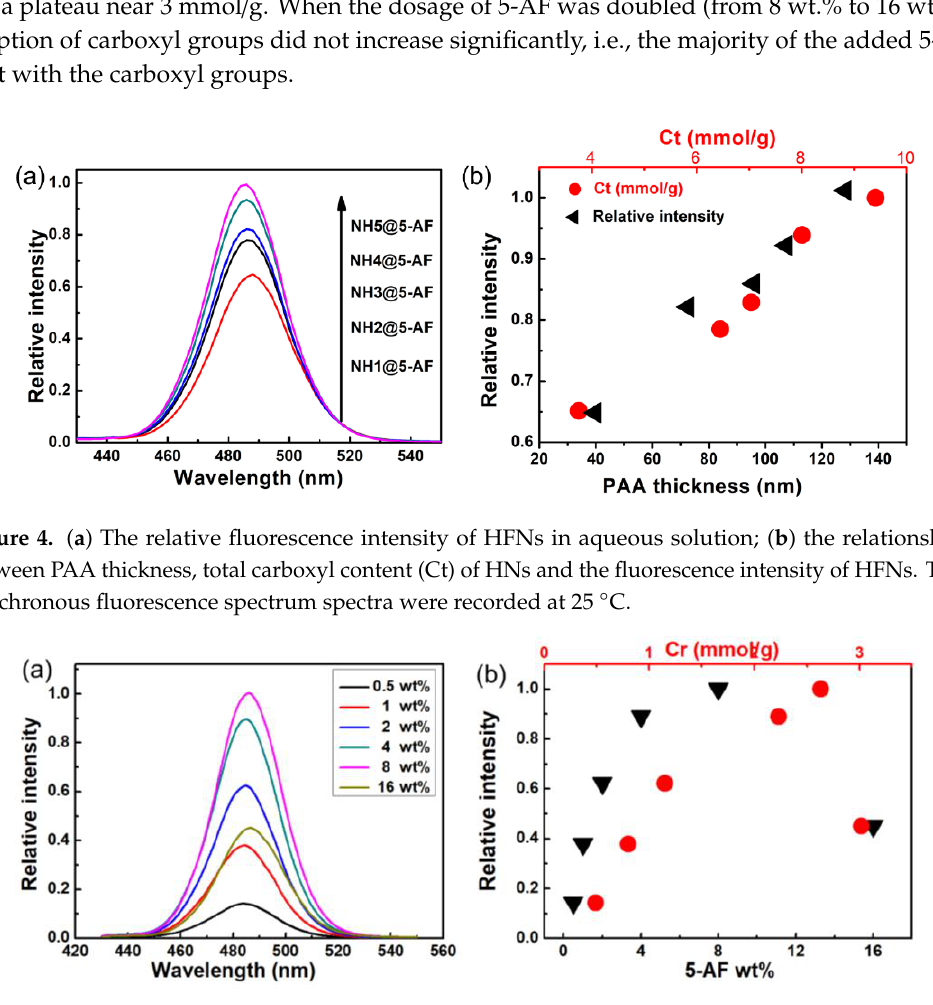
Figure 5. ( a ) The relative fluorescence intensity of HFNs with di ff erent contents of 5-AF in aqueous solution; ( b )therelationshipbetweenthe5-AFdosage, reactedcarboxylcontent(Cr)andthefluorescence aqueous solution; ( b ) the relationship between the 5-AF dosage, reacted carboxyl content (Cr) intensity of HFNs. (The core of HNs used here is 77 nm and the thickness of PAA chain is 139 nm). The synchronous fluorescence spectrum spectra were recorded at 25 ◦